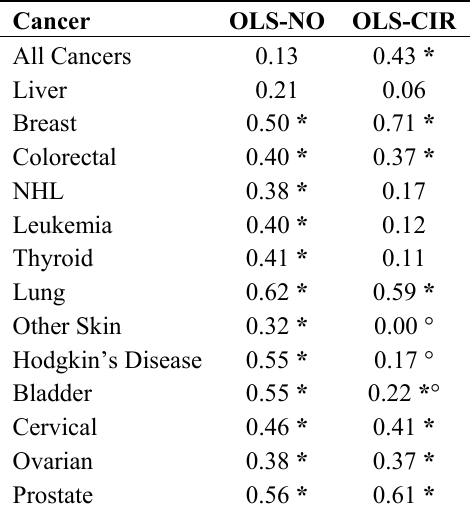
and the most common cancers at the regional 2